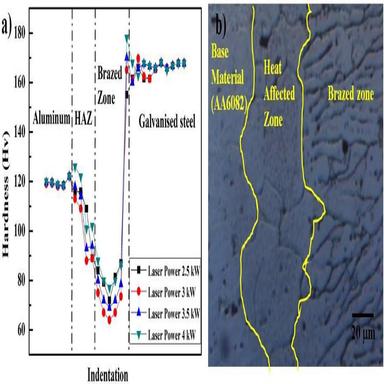
(a) Microhardness profile of laser brazed joints with varying laser powers (b) microstructure showing HAZ.